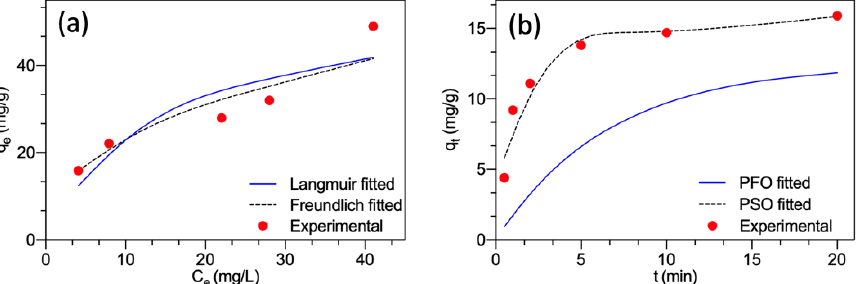
Figure 4. ( a ) Fitting plots of the Langmuir and Freundlich models; ( b ) Fitting plots of the pseudo- first-order and pseudo-second-order models.